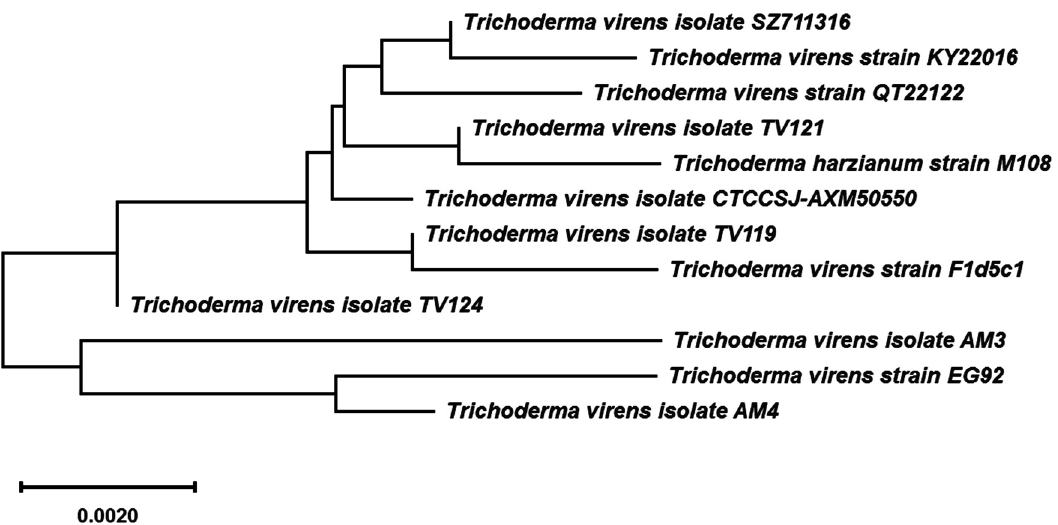
Figure 1. Phylogenetic tree and diversity of partial sequence of small and large subunit ribosomal RNA genes (internal transcribed spacer 1, 5.8S ribosomal RNA gene, and internal transcribed spacer 2) in endophytic Trichoderma virens strain EG92 (MF429775) compared with reference strains. This tree constructed using the neighbour-joining and maximum likelihood analysis ( MEGA10.1.7 software 2020 ). The sequence divergence is indicated by a scale